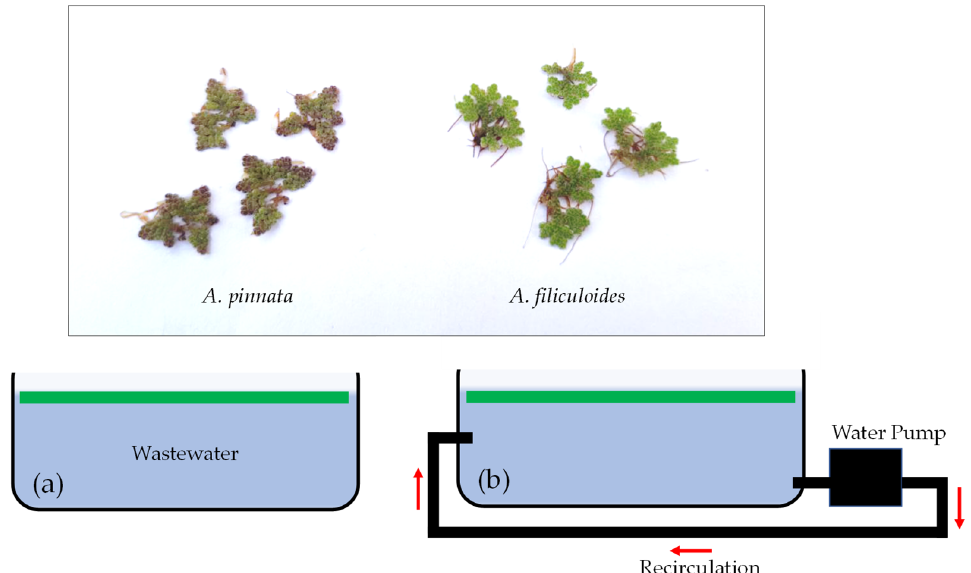
Figure 2. Experimental layout of ( a ) stagnant and ( b ) flowing tank reactors for the treatment of MFW using two Azolla spp. (Photographs: Pankaj Kumar and Ashish Kumar Arya). using two Azolla spp. (Photographs: Pankaj Kumar and Ashish Kumar